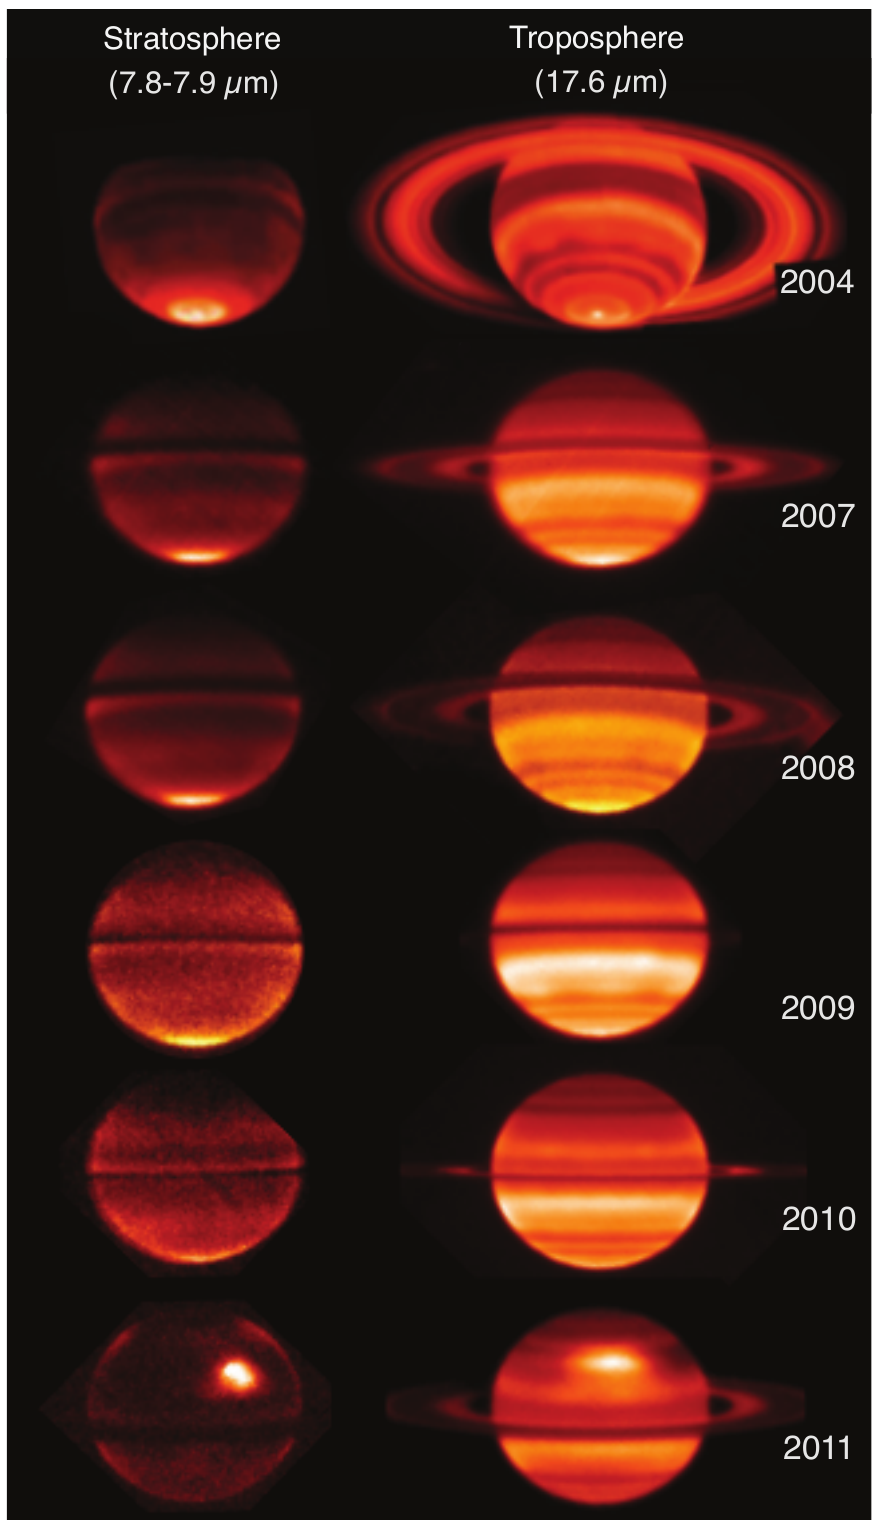
Figure 17. Saturn images showing changes between 2004 and 2012, adapted from [65]. Images sense stratospheric temperatures via methane emission at 7.8 µ m ( left ) and tropospheric temperatures via collision-induced hydrogen at 17.6 µ m ( right ). Images are from Keck-LWS (2004) [394], Subaru- COMICS (2007), and VLT-VISIR (2008-2012). Note the prominent warm spot associated with a remarkable storm in the northern hemisphere in 2011